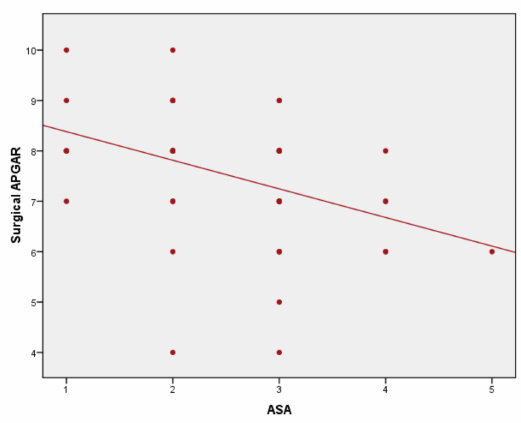
Figure 2. ASA score–Surgical APGAR Score (SAS) correlation.